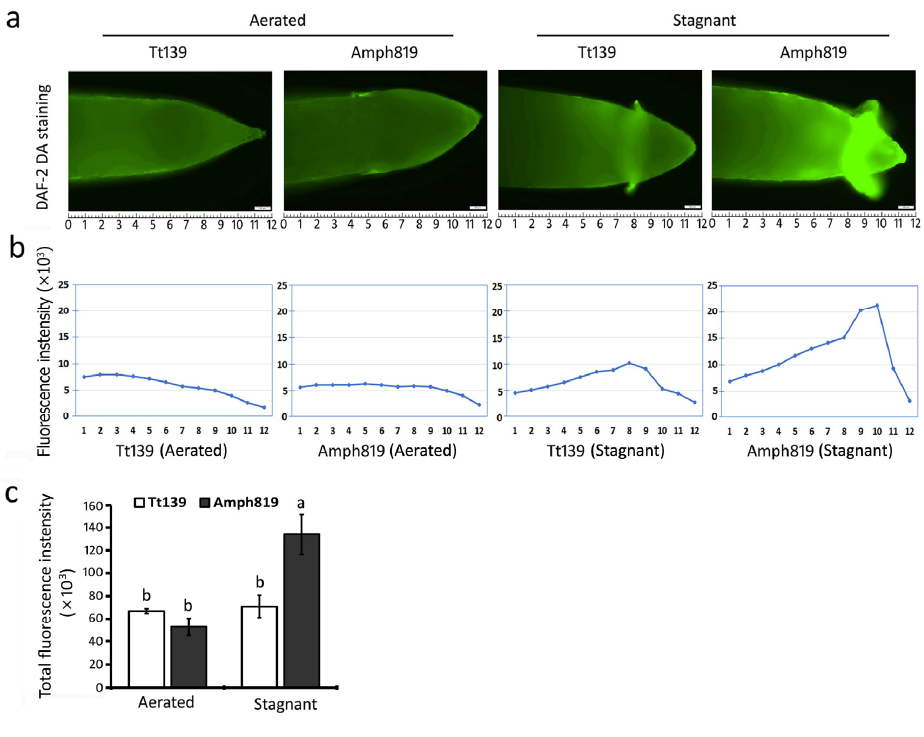
Figure 6. Fluorescent detection of nitric oxide (NO) in root tips of seedlings grown under aerated and stagnant conditions for 2 weeks. ( a ) Detection of NO accumulation by fluorescent staining with DAF 2-DA in root tips. Genotypes and growth conditions are indicated on the top. ( b ) Fluorescence intensity at the corresponding position of the root tip. The numbers underneath indicate the positions from the root tips corresponding to that in ( a ). ( c ) Total fluorescence intensity of the root tips. Values are means ± SE ( n = 4). Letters indicate significant differences between means, determined using Duncan’s multiple range test (5% α ).